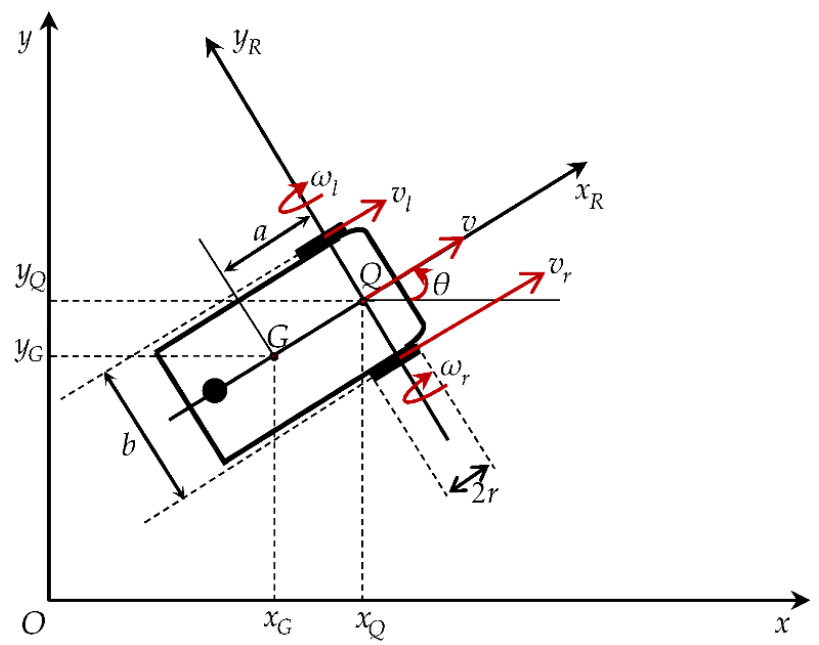
Figure 3. Geometry of a differential drive robot. Table 1. The parameters of the differential drive robot. No 01 02 The orientation of the DDR ( θ ) 03 The angular velocity of the right wheel () 04 The angular velocity of the left wheel ( 05 The linear velocity of the right wheel () 06 The linear velocity of the left wheel ( 07 The radius of the right and the left wheels ( r ) 08 The distance between the right and the left wheels ( b ) 09 The center of the axis between the right and the left wheels ( Q ) 10 The center of gravity of the DDR ( G ) 11 The distance between Q and G ( a )